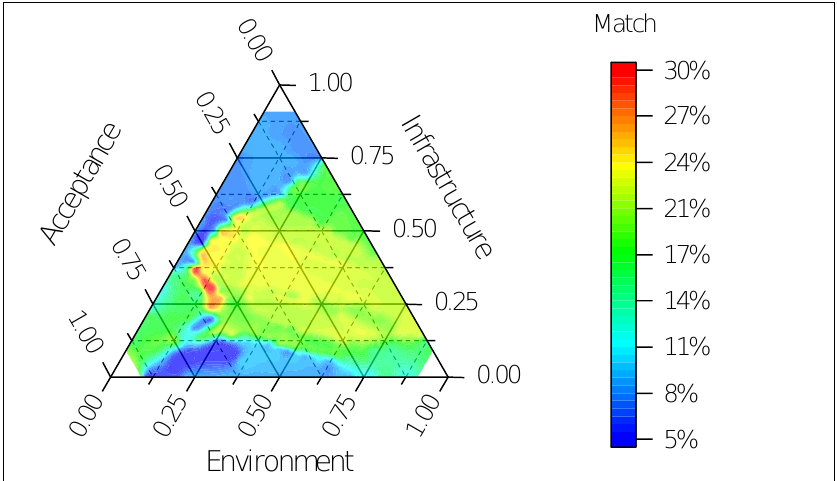
Figure A2. Deviations of the different calculated routes from the route corridor which has been proposed officially by the responsible transmission system operators. Own